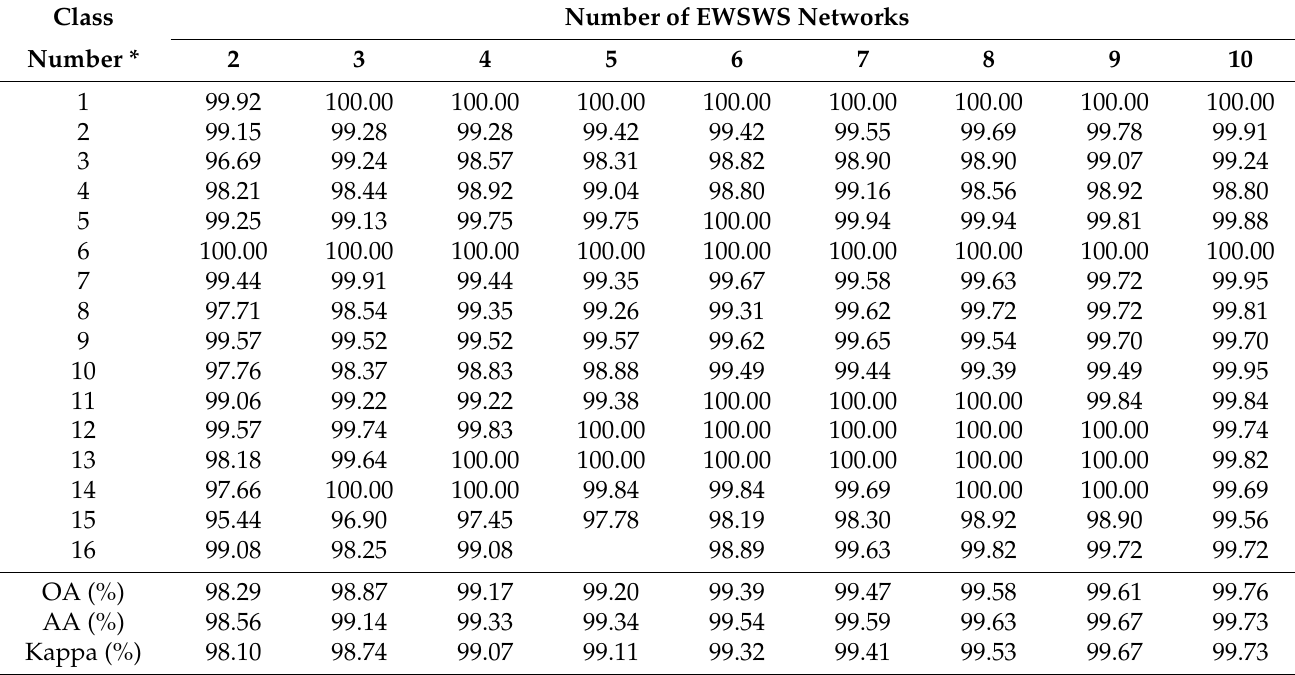
Table 8. Classification results with different numbers of EWSWS networks with the Salinas dataset.